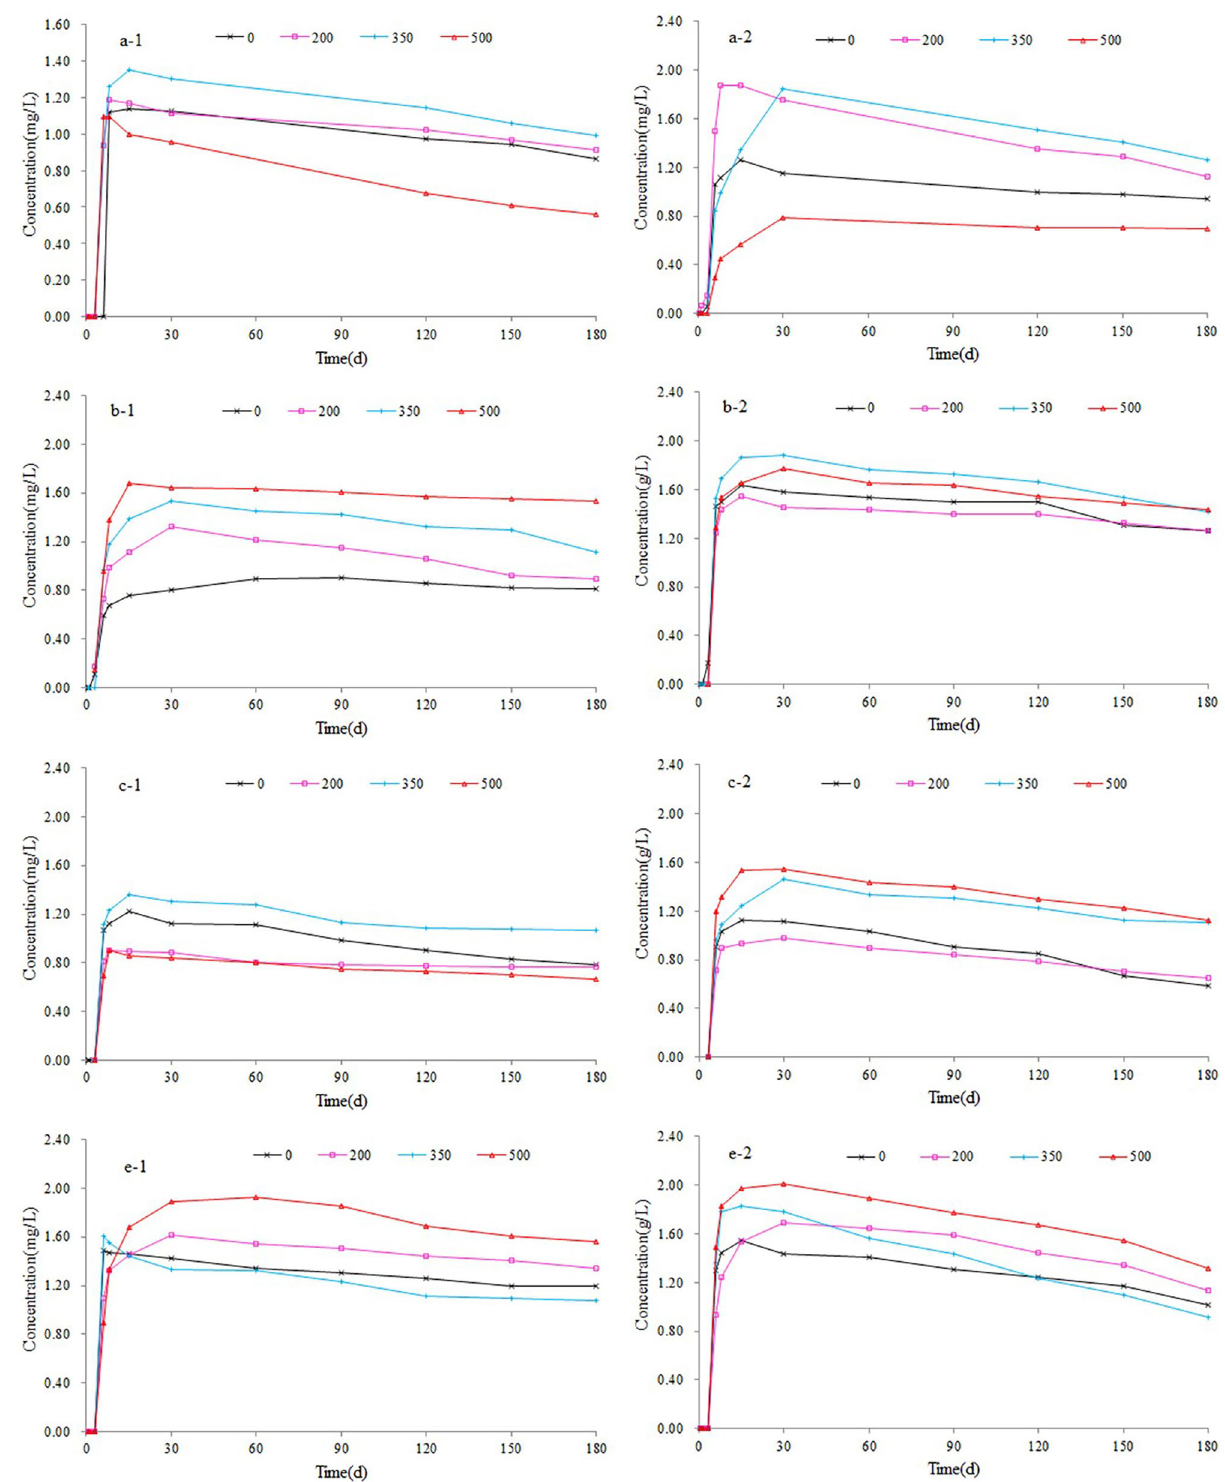
Figure 4. Change in the benzene series concentration over time in the four samples, where -1 indicates benzene and -2 indicates